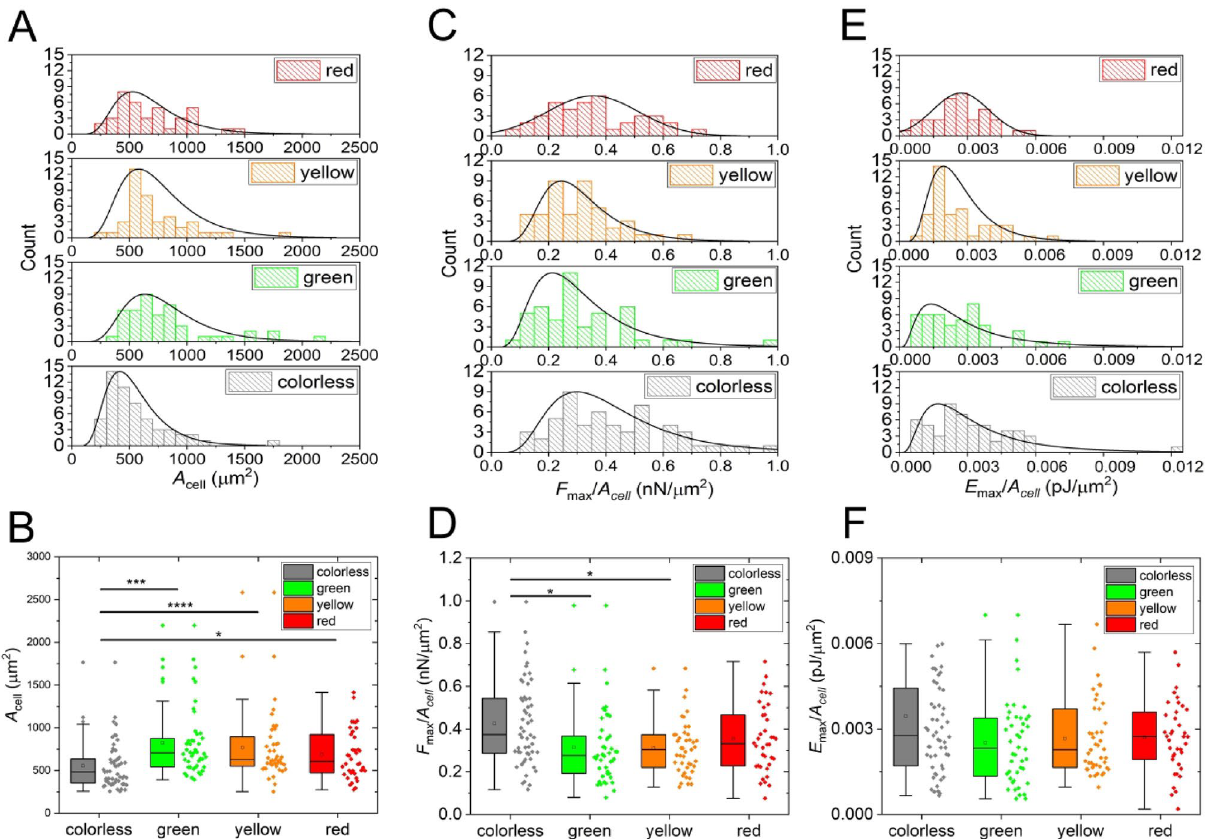
Figure 5. Area ( A cell ) and its effect on the area normalized parameters ( F max / A cell , E max / A cell ,) presented on histograms with fits of lognormal distributions ( A,C,E ) and box charts ( B,D,F ). A significant difference was found in the A cell between colorless cells and all other subpopulations ( B ). Also, the F max / A cell values between colorless cells, green and yellow cells were observed to be significantly different ( D ). E max / A cell has not shown any difference in their distribution ( F